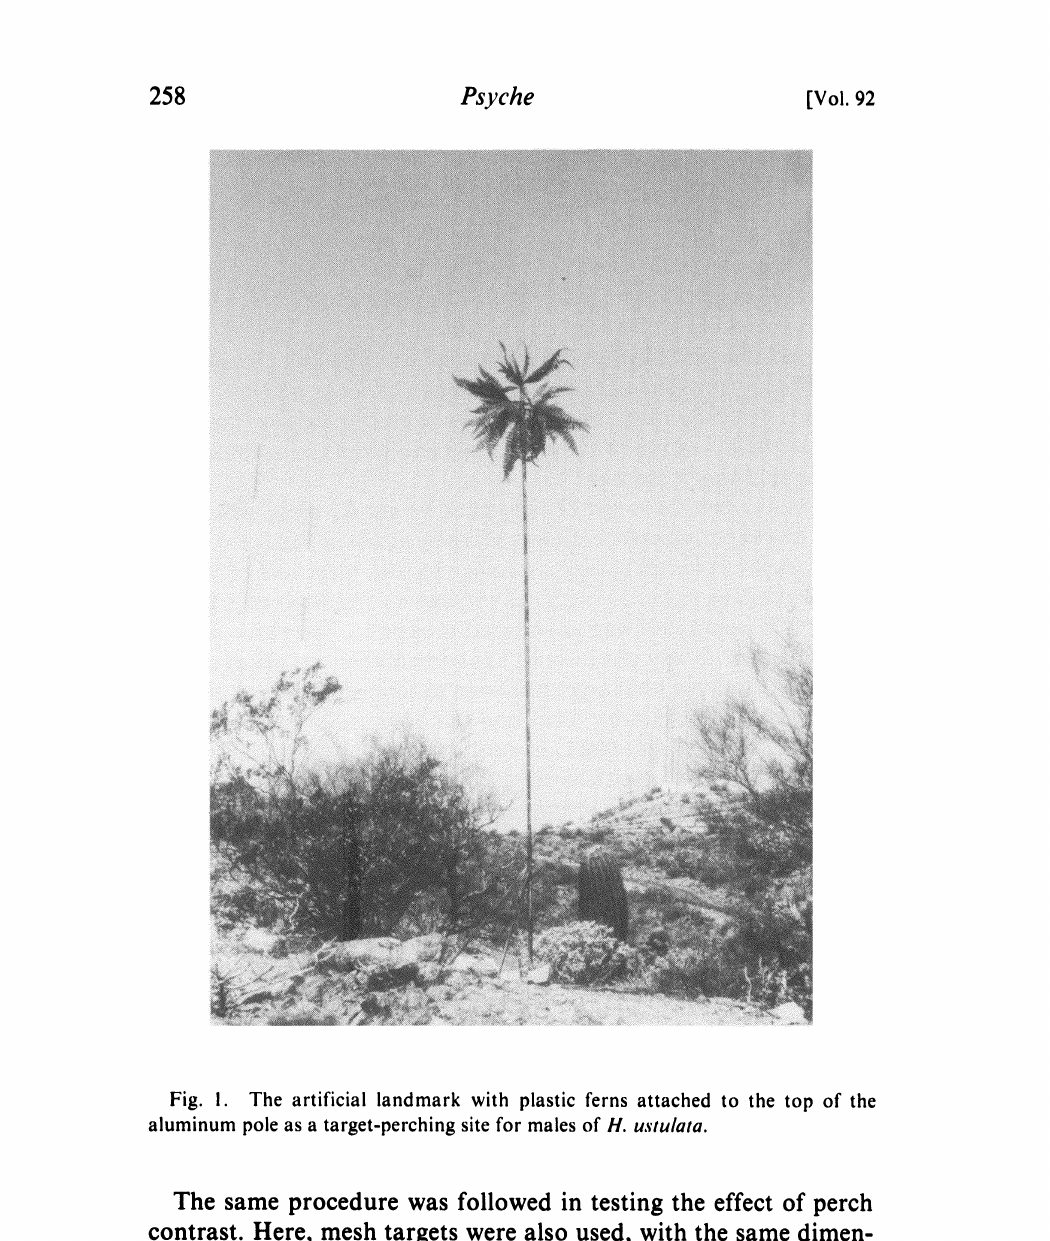
Fig. I. The artificial landmark with plastic ferns attached to the top of the aluminum pole as a target-perching site for males of H. ustulata. The same procedure was followed in testing the effect of perch contrast. Here, mesh targets were also used, with the same dimen- sions as the larger target employed in the preceding experiment, but one target composed of plastic mesh was painted green while the other wire mesh target was painted flat